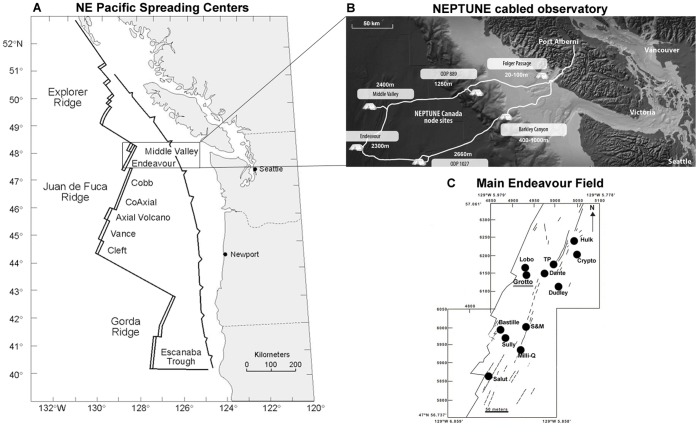
Location and lay-out of NEPTUNE observatory and TEMPO-mini study-site.Location (a) and lay-out (b) of the NEPTUNE cabled observatory on the northern Juan de Fuca plate. The NEPTUNE network contains multiple instrumented nodes (b). The Endeavour node connects the instrument platforms and the instruments at the Main Endeavour Field and contains the TEMPO-Mini module, which has been deployed at Grotto hydrothermal vent (c). MEF map based on [57] and V. Robigou (1995) (unpublished data).